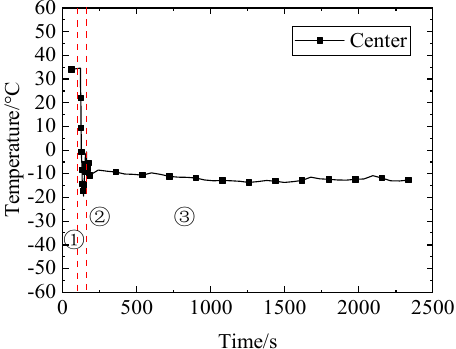
Center Figure 16. Temperature change curve with time in response phase under 6200 W/m 2 heat flux. Table 8. Experimental data of three stages under 6200 W/m 2 heat flux. Heat Flux (W/m 2 )